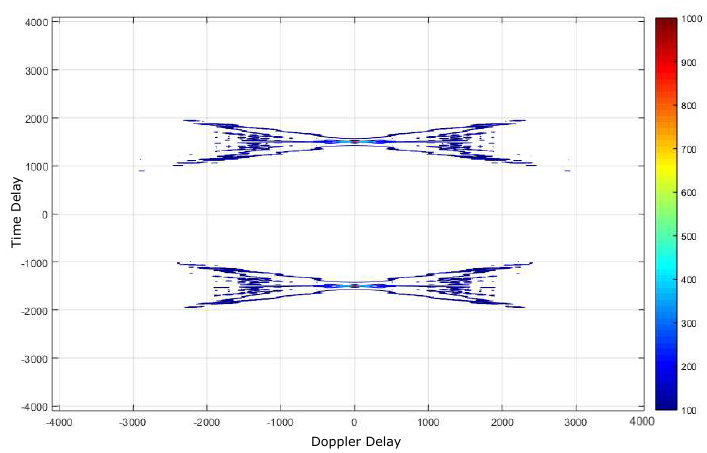
Figure 17. Two nearby scatterers using chirp pulses (MMPP): -2D, with no noise.